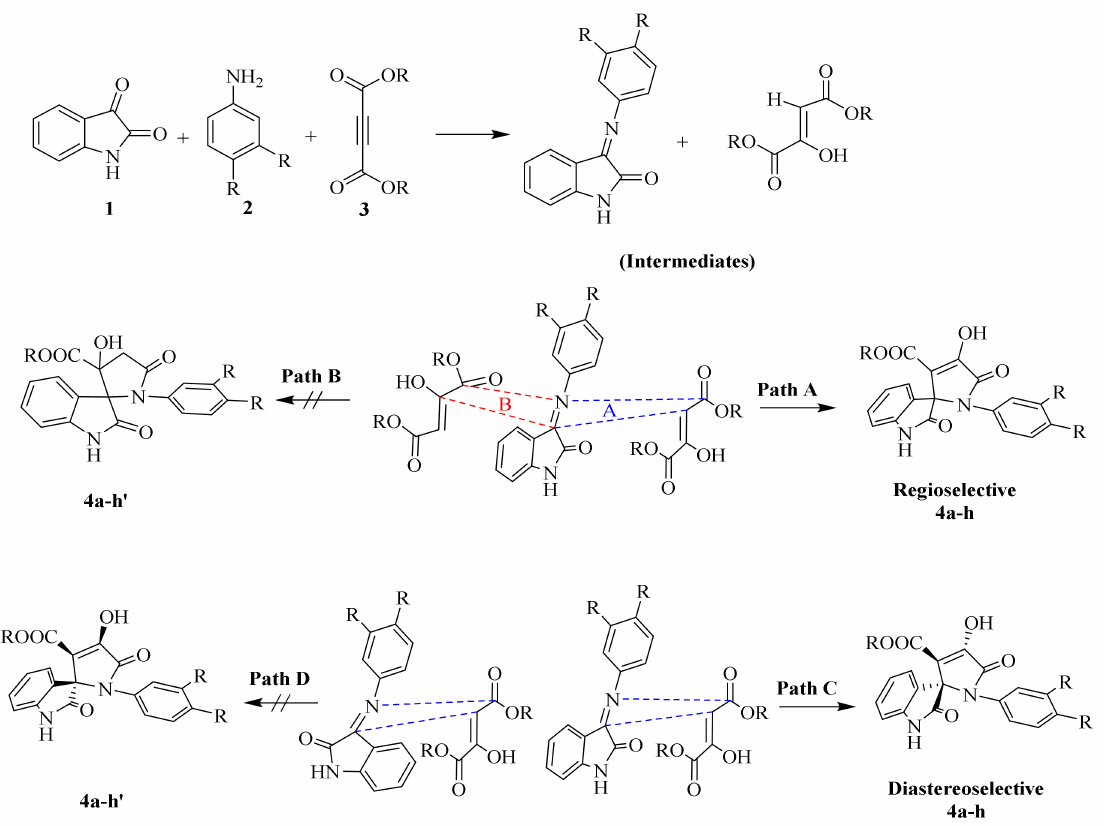
Scheme 3. Plausible approach of 1,3-dipolar cycloaddition for the formation of regio- and diastereos- elective spirooxindole-pyrrolines ( 4a – h